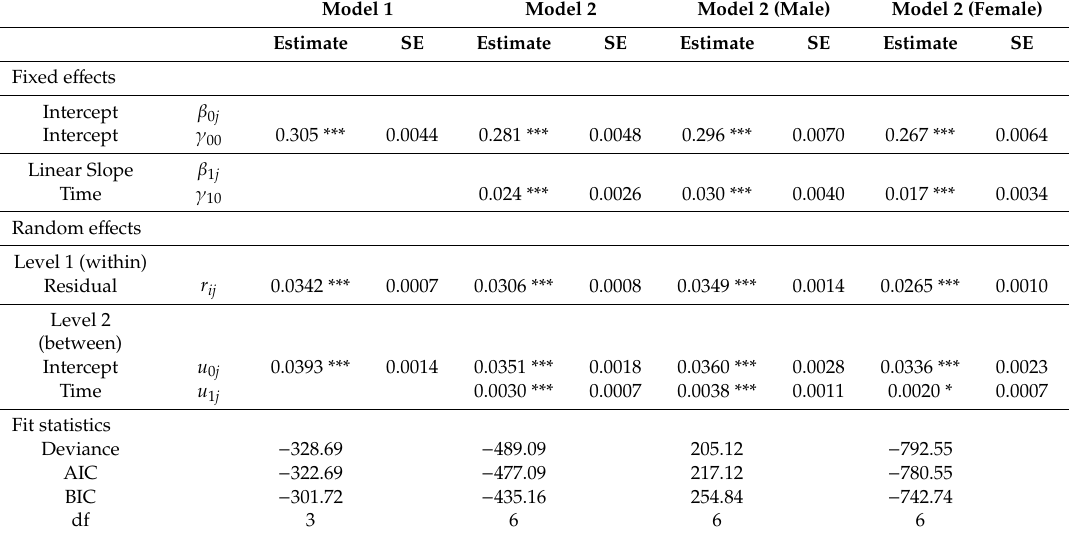
Table 4. Results of individual growth curve (IGC) models with Level-1 predictors for adolescent delinquency (Waves